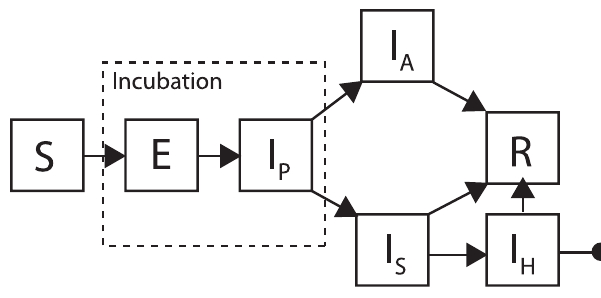
Figure 1. The Natural History Assumed for Pandemic